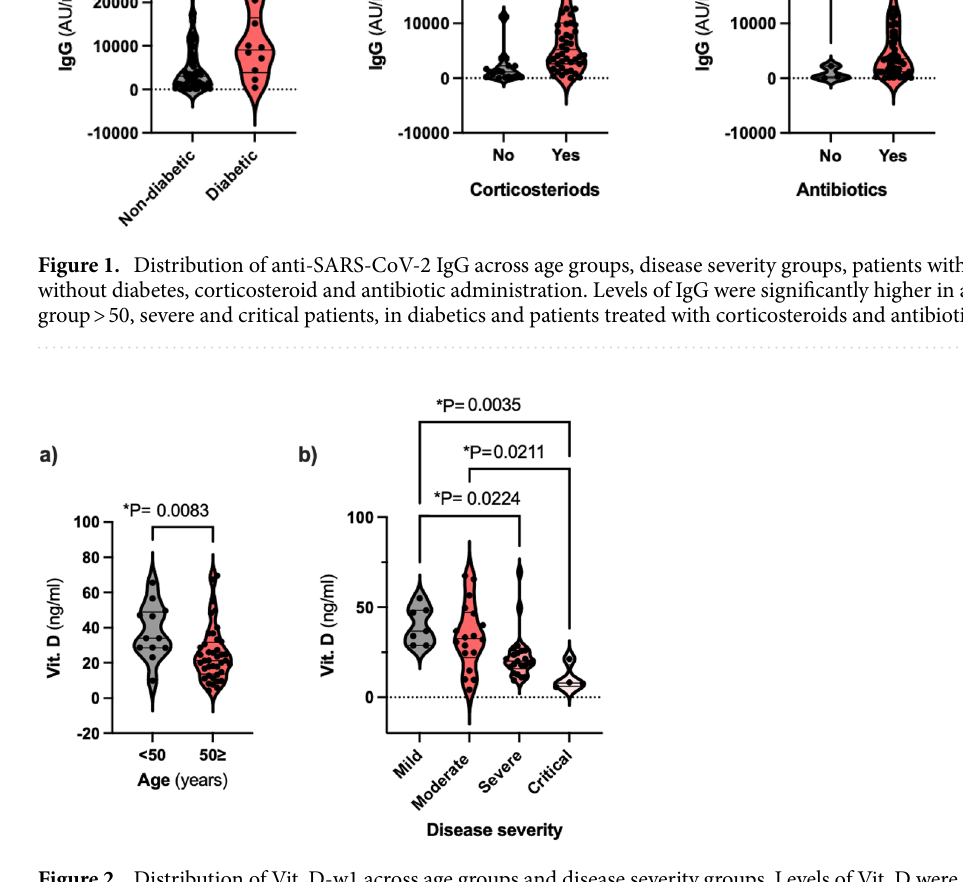
Figure 2. Distribution of Vit. D‑w1 across age groups and disease severity groups. Levels of Vit. D were significantly higher in the age group < 50 and in mild/moderate